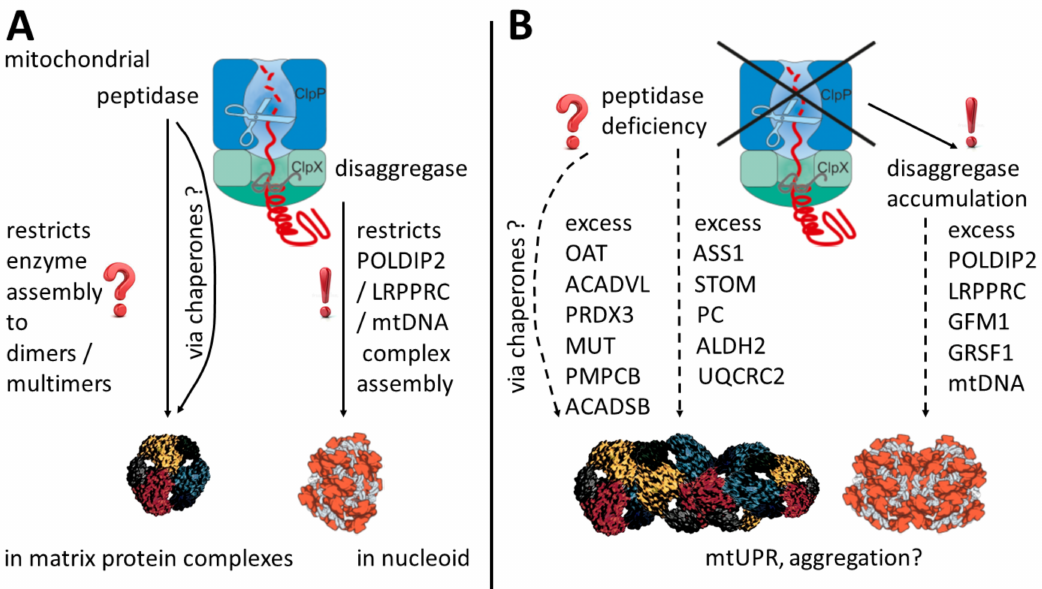
Figure 6. Schematic overview of potential mechanisms in the presence ( A ) and absence ( B ) of ClpP. ClpP inactivating variants act via ClpX accumulation on mitochondrial nucleoid/RNA granule components, triggering excess POLDIP2, LRPPRC, GFM1, GRSF1, and mtDNA abundance, as well as an enlarged nucleoid area, as a clear result of this study. Less consistent across cell types and potentially without ClpX interactions, multimerizing enzymes in the matrix also show increased abundance. In parallel, elevated levels of varying molecular chaperones suggest a mitochondrial unfolded protein response and aggregation tendencies. OAT multimer and nucleoid shapes were adapted from Refs.